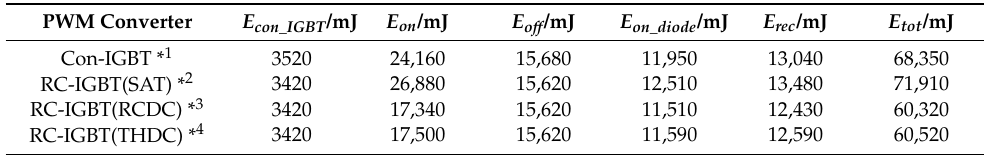
Table 3. Datasheet of loss for conventional insulated gate bipolar transistor (IGBT) and RC-IGBT PWM converters.